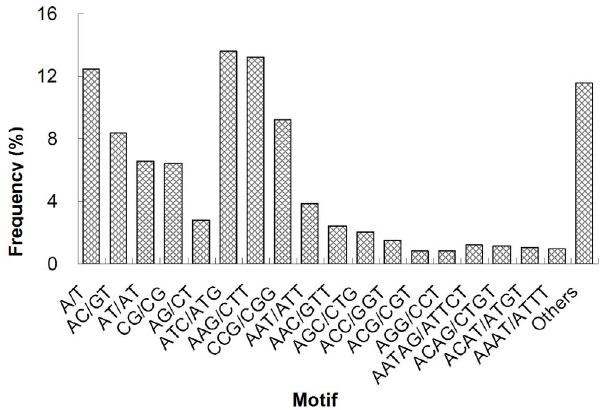
Figure 5. Frequency distribution of SSRs based on motif types. The frequency of main motif types was displayed.